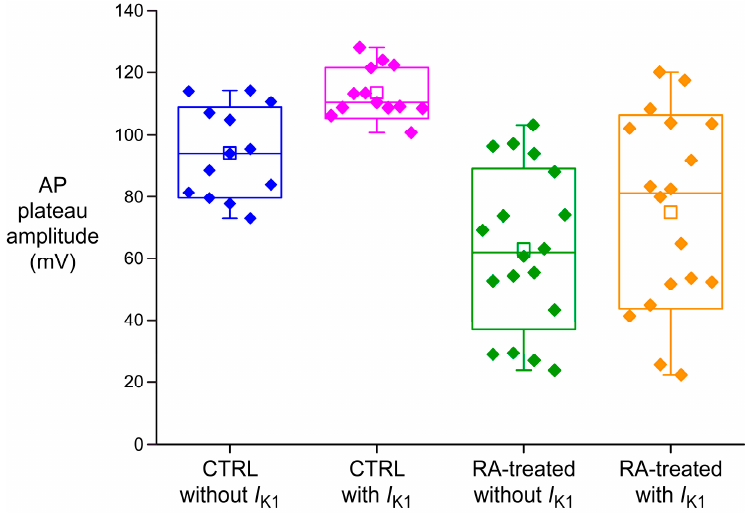
Figure 4. Standard box plot of the AP plateau amplitude of all CTRL and RA-treated hiPSC-CMs measured ( n = 13 and n = 18, respectively), both with and without I K1 injection.